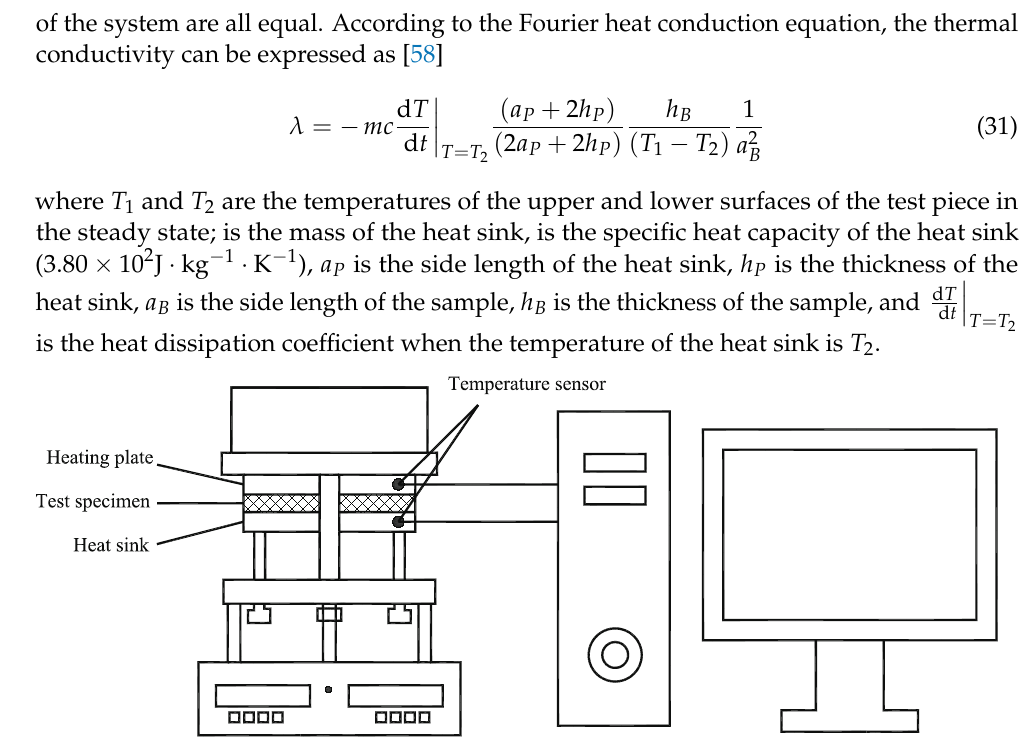
Figure 10. Structure diagram of thermal conductivity